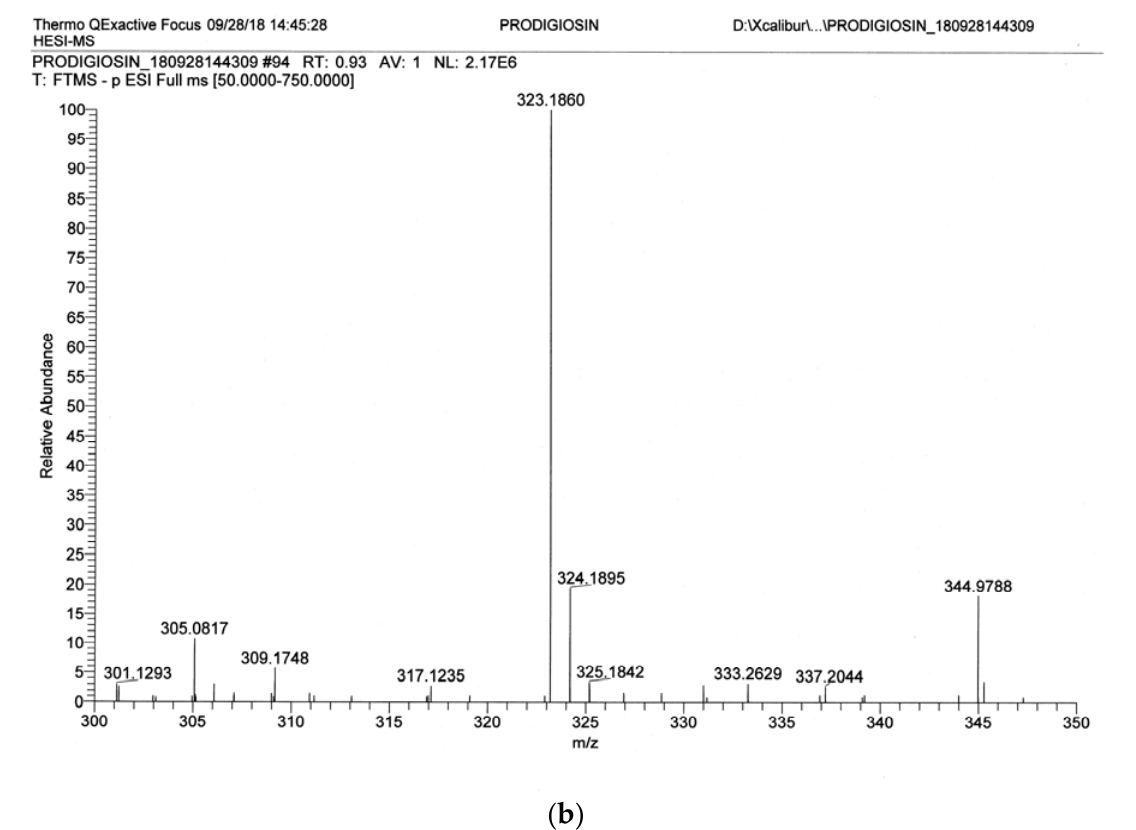
Figure 4. The UV/vis spectrum ( a ), and the mass (M = 323.186) ( b ) of the red pigment compound biosynthesized in this study.